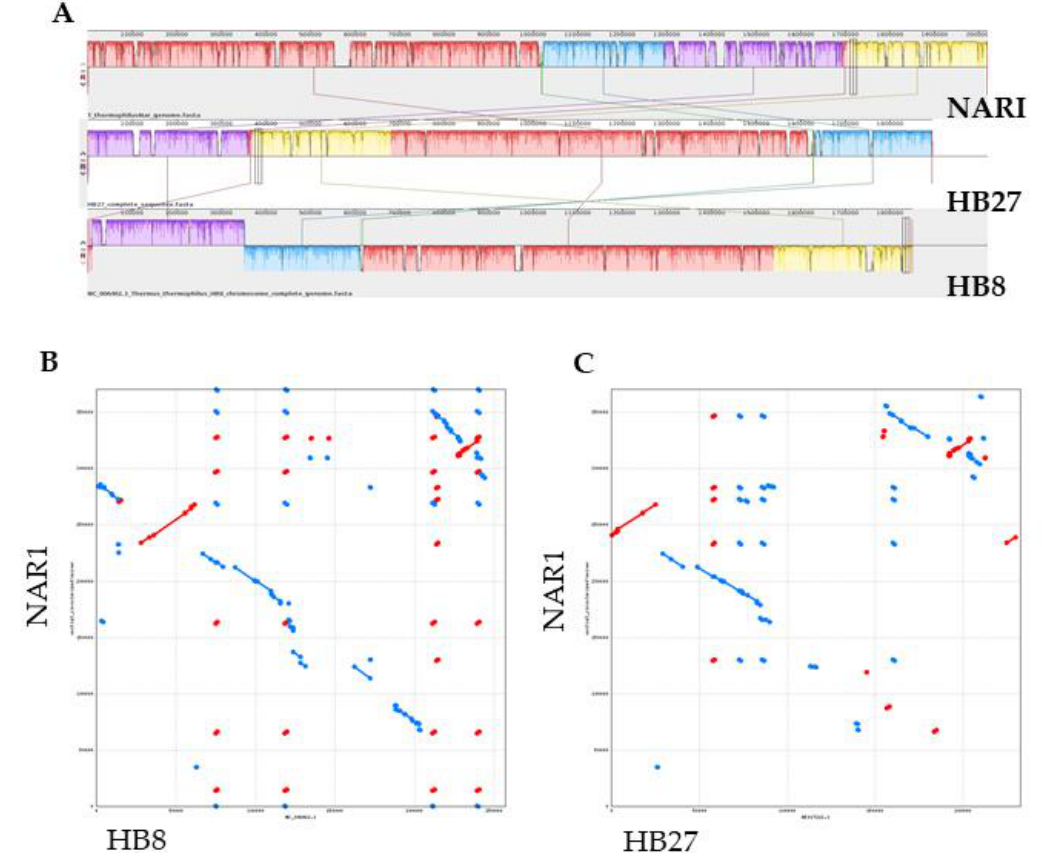
Figure 2. Synteny of TthNAR1 replicons with other Tth strains. ( A ) Alignment of (top to bottom) Tth strains NAR1, HB27 and HB8 chromosomes with Mauve (no connection lines). The sequence has been divided in four section colors corresponding to syntenic regions to facilitate the visualization. Dotplots of TthNAR1 370 kbp megaplasmid against pTT27 megaplasmids found in HB8 ( B ) and HB27 ( C